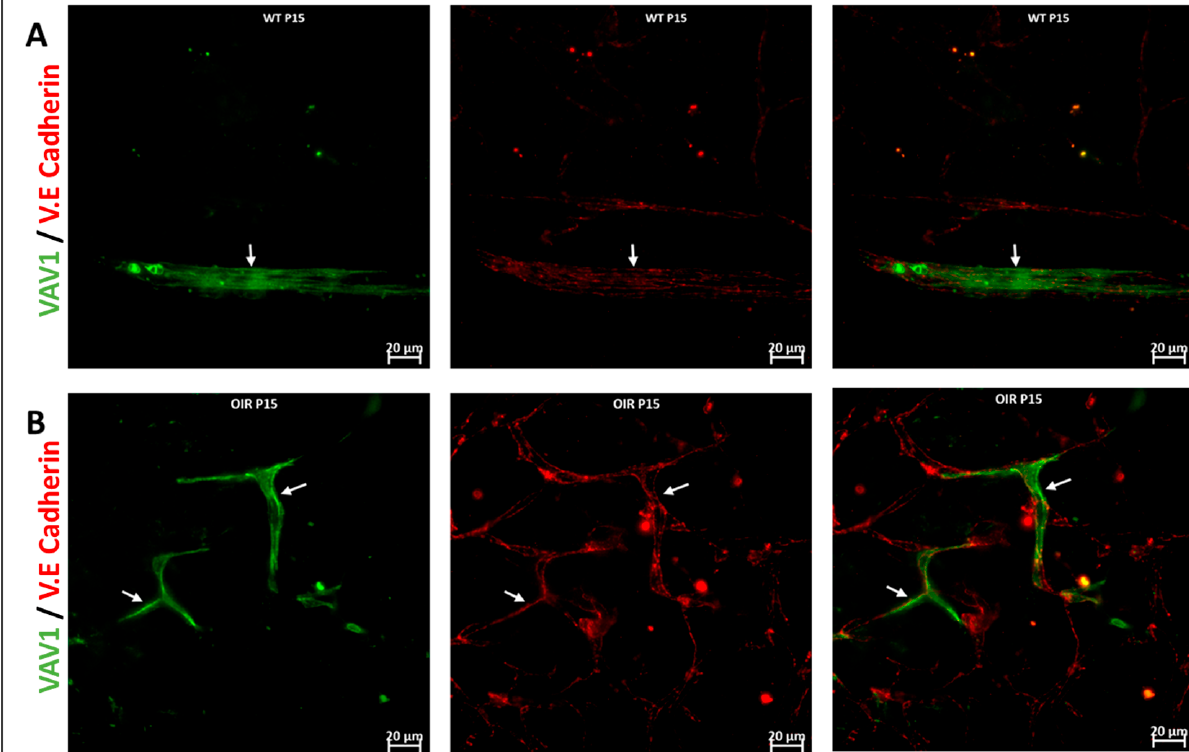
Figure 6. Hematopoietic cells in abnormal vascular development and repair. Representative images ( A , B ) showing retinal flat mounts of Vav1-GFP without OIR ( WT ) and with OIR (OIR) at 3 days (P15; ( A , B )) and 5 days (P17; ( C , D )) post OIR. At P15, GFP + hematopoietic cells are observed forming close association with the vasculature in both models (white arrows). At P17, the peak of neovascularization, recruited GFP + hematopoietic cells are observed to align/aggregate (( D ) , inset) to remodel or repair a damaged vessel in the developing retina. 4. Discussion The major findings of this work include that hematopoietic cells are recruited early in development and participate in the formation of the healthy retina mainly as microglia and by facilitating retinal angiogenesis. GFP + cells in the retina appear as early as less than 24 h after birth (P0) and reached steady levels from P7 to P21 with the majority of these